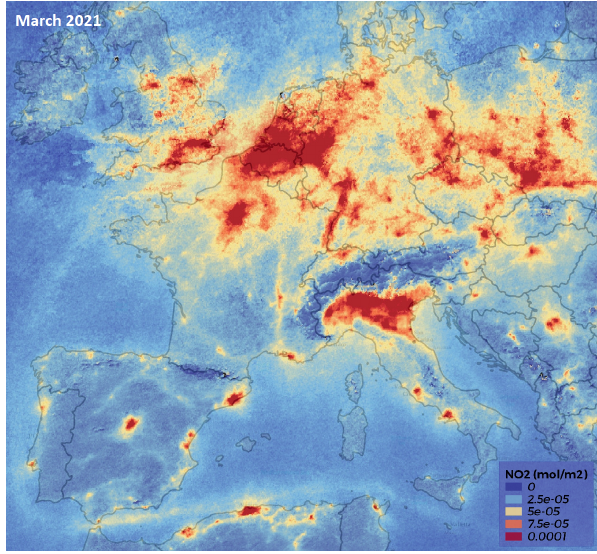
Figure 1. NO 2 levels in Europe in March 2021.